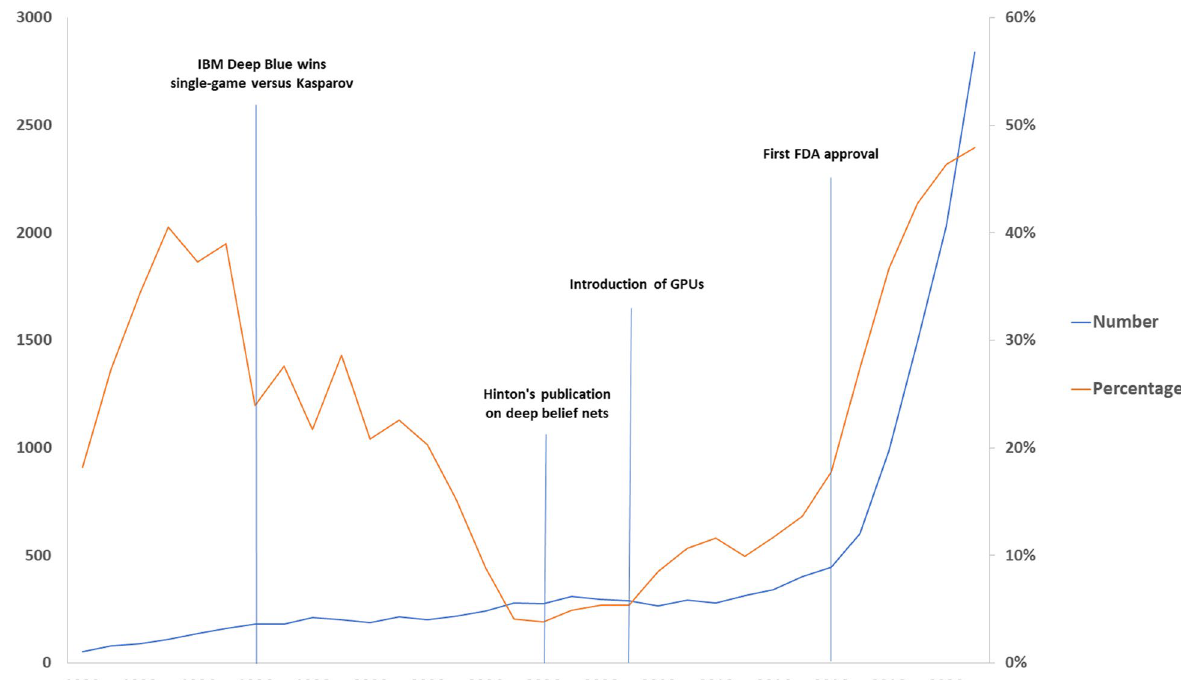
Fig. 3 Number of articles on artificial intelligence (AI) in the field of medical imaging and percentage of those declaring the use of AI in the title. Four major milestones are shown. FDA Food and Drug Administration, GPU Graphics processing